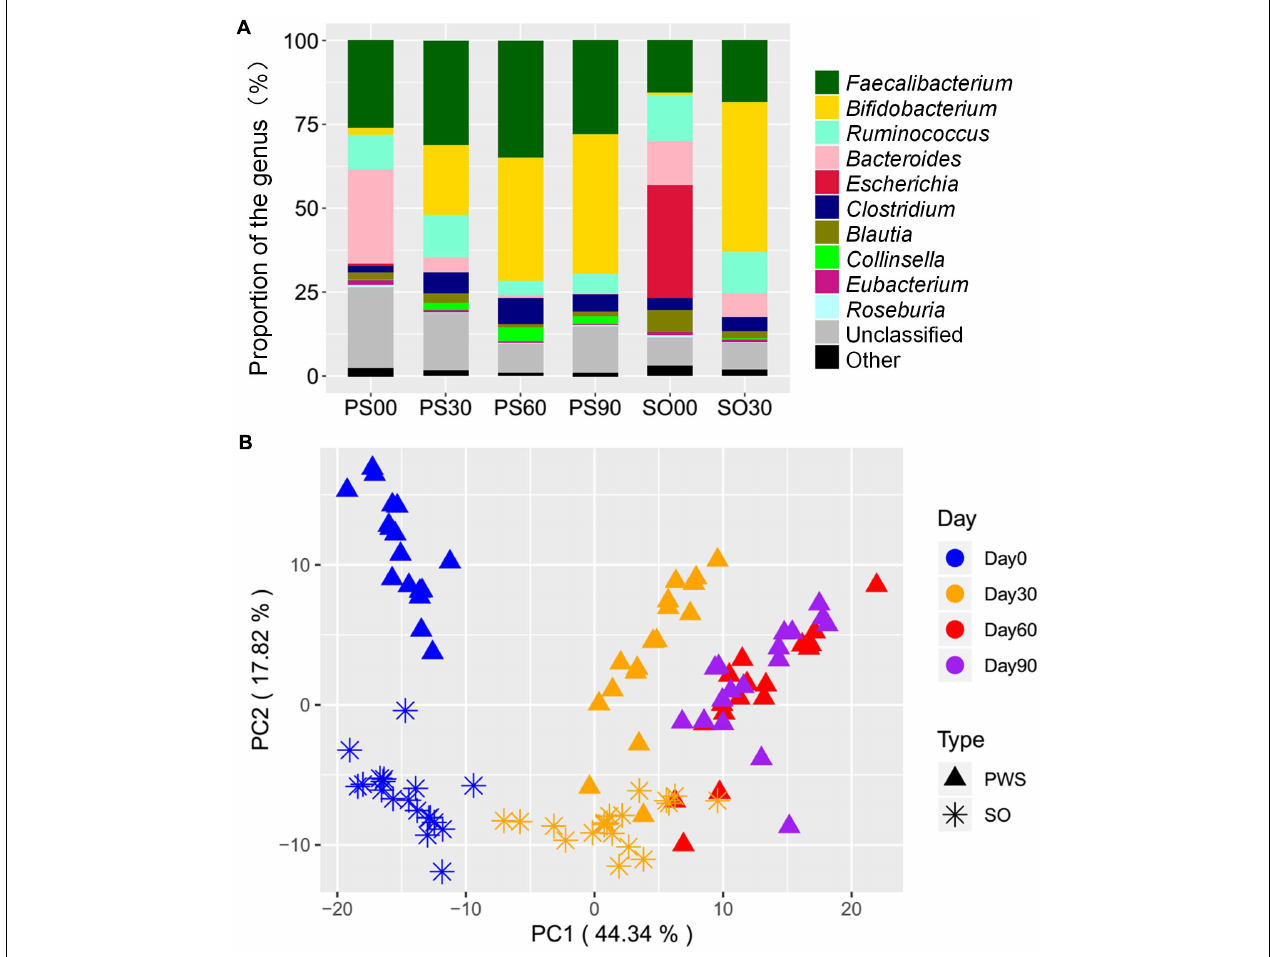
FIGURE 1 | High-fiber dietary intervention altered gut microbial single-nucleotide polymorphism (SNP) pattern in both Prader–Willi syndrome (PWS) ( n = 17) and simple obese (SO) ( n = 19) children. (A) The composition of SNPs at the genus level among different interventional time points. PWS on day 0 (PS00), 30 (PS30), 60 (PS60), and 90 (PS90); SO on day 0 (SO00) and day 30 (SO30). (B) PCA plot based on the SNP density of gut